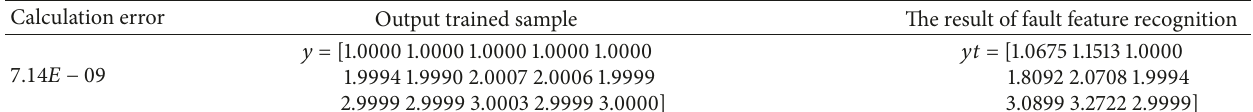
Table 4: Results of the operation of fuzzy neural network.